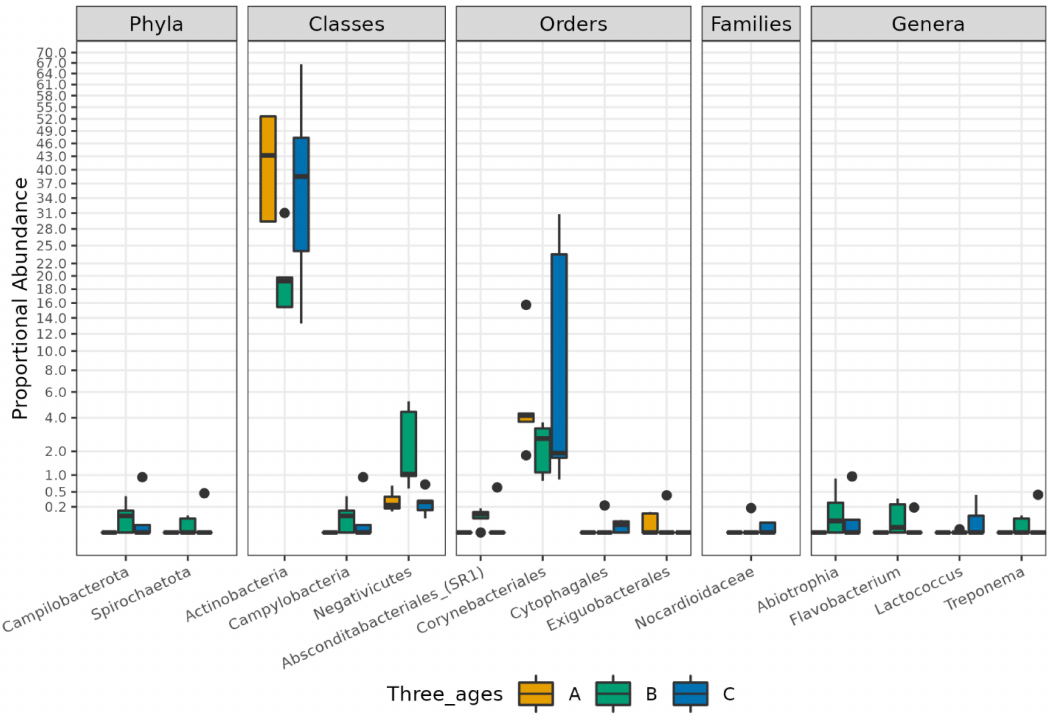
Figure 5. Boxplot showing the results of taxa differential abundance analysis between the three groups of subjects. Y axis has been scaled to improve the readability of values. All results have an adjusted p -value <